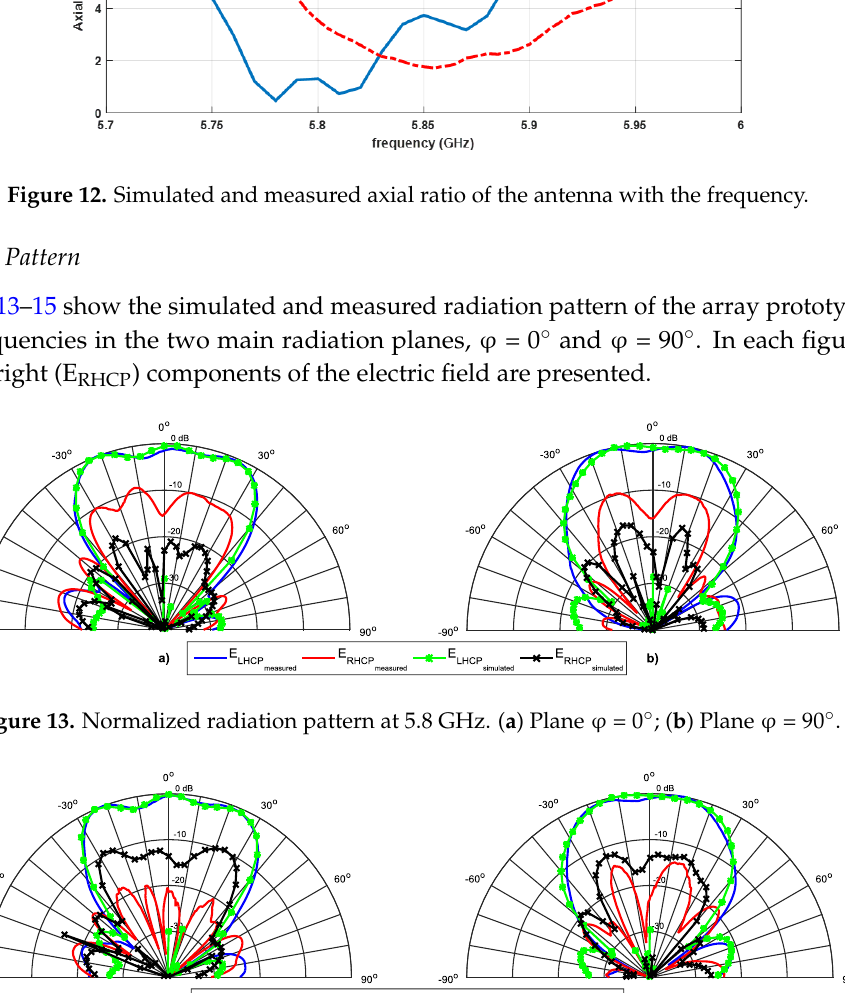
Figure 14. Normalized radiation pattern at 5.85 GHz. ( a ) Plane φ = 0°; ( b ) Plane φ = 90°.